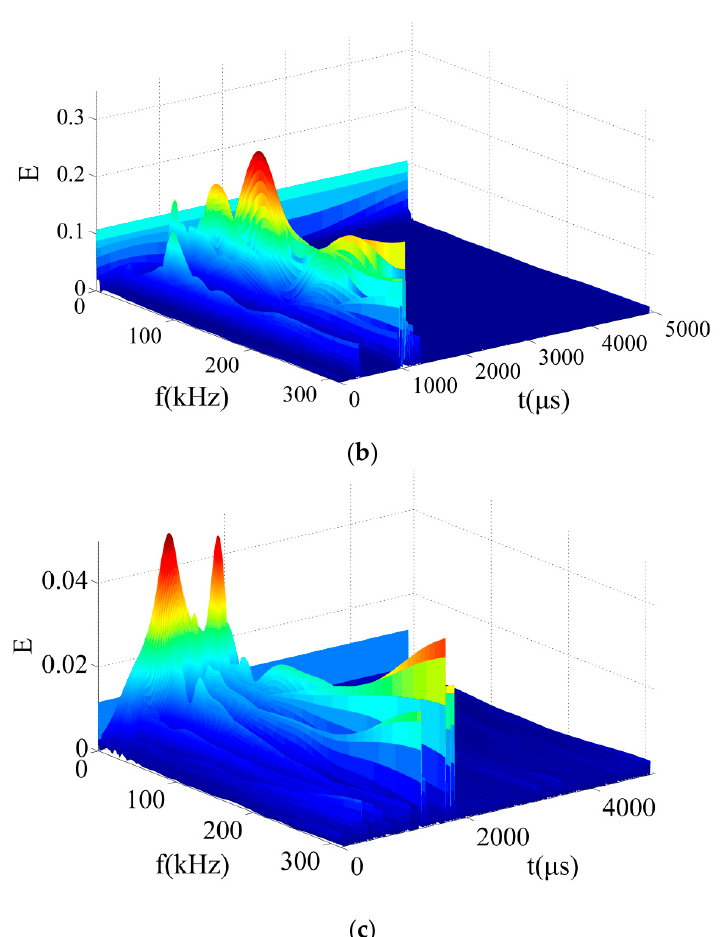
Figure 10. S-transform matrix of the zero-sequence voltage signal. ( a ) Lightning induced overvoltage; ( b ) Switching capacitor bank overvoltage; ( c ) Switching-off transformer overvoltage.